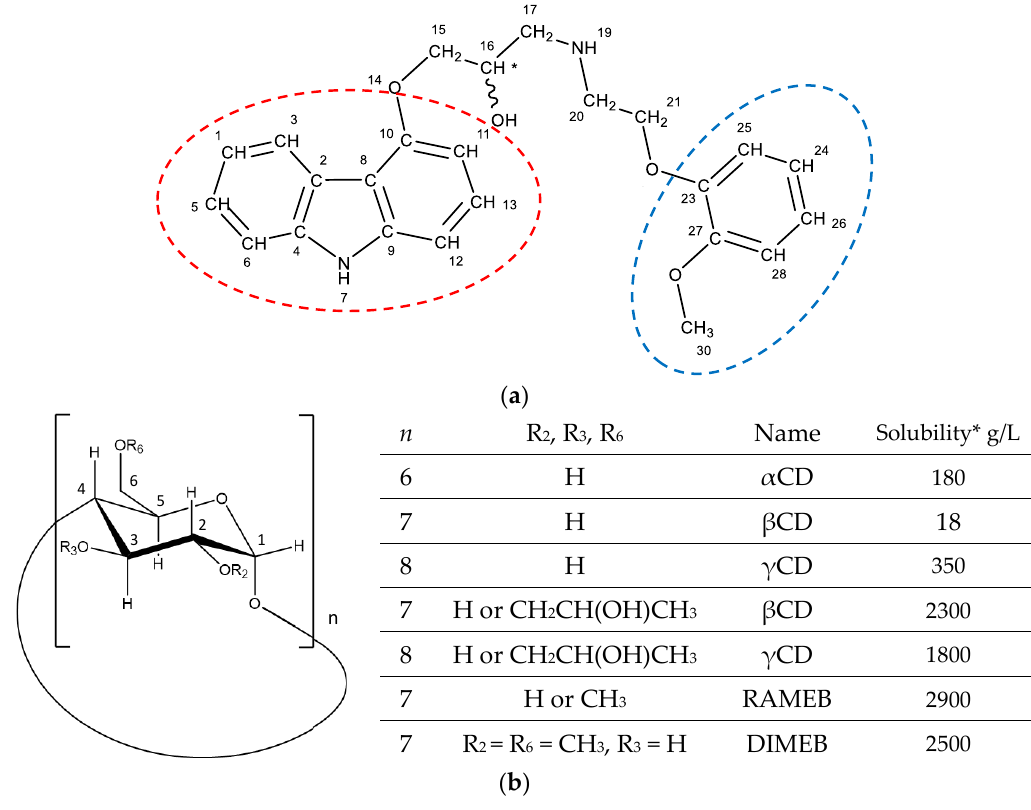
Scheme 1. Numbered chemical structures of ( a ) carvedilol (carbazole and methoxyphenyl groups are highlighted by red and blue circles, respectively) and ( b ) the CDs used in the present study. * Solubility in water at 24 °C.